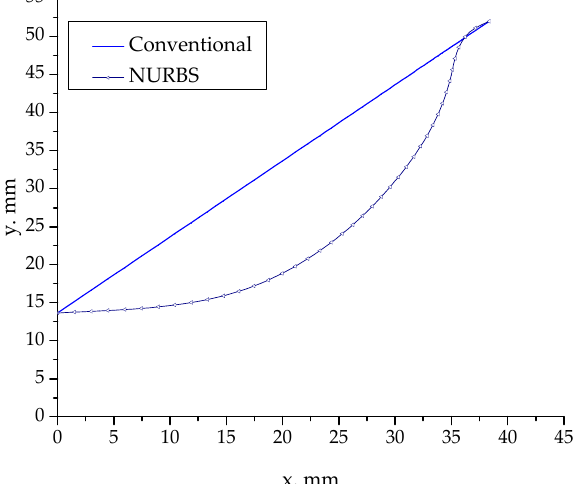
Figure 3. The shapes of the conventional cone and the nonuniform rational B-splines (NURBSs)